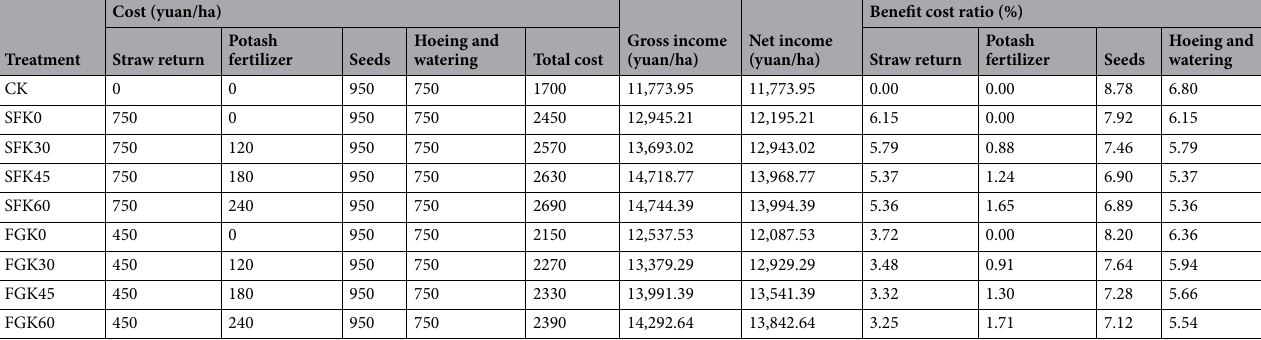
Table 2. Itemization of maize planting cost of different treatments during 2018 to